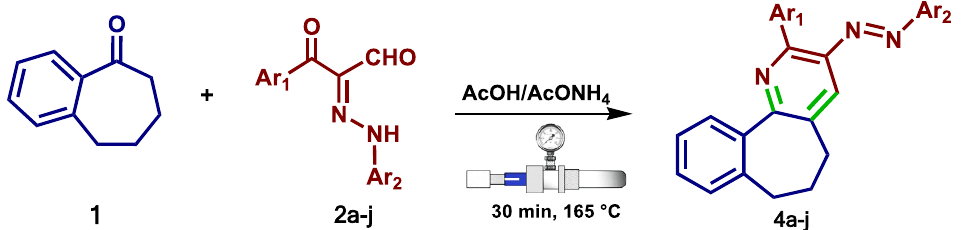
Table 3. Cyclocondensation reactions between benzosuberone ( 1 ) and arylhydrazonals 2a–j using Q-tube.